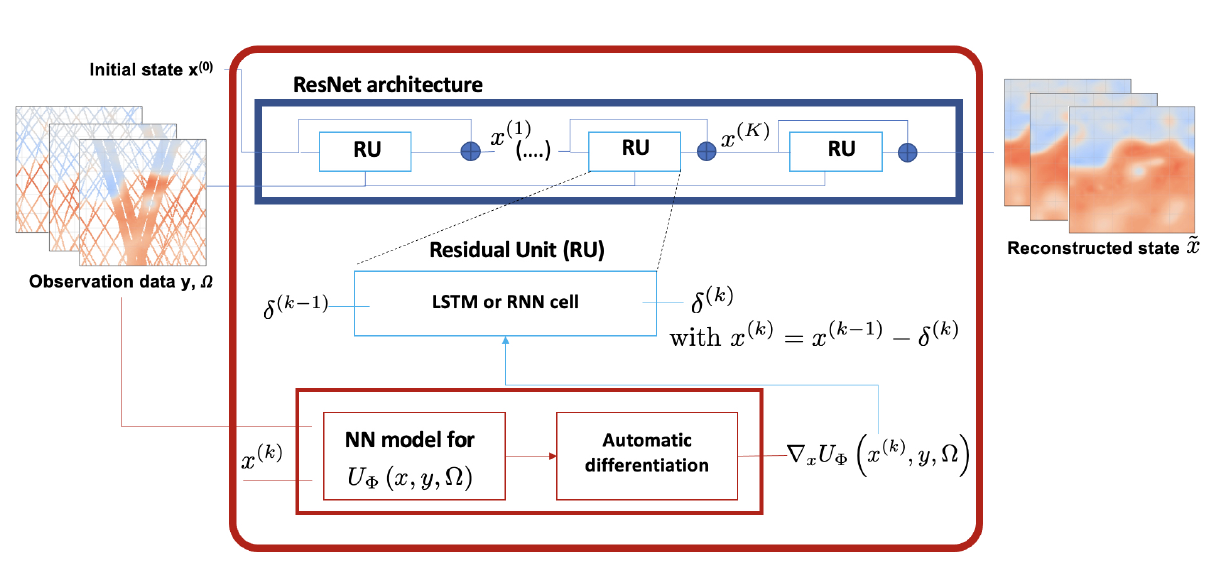
Figure 1. Sketch of the proposed end-to-end architecture for the reconstruction and forecasting of sea surface dynamics from irregularly-sampled satellite observations: the proposed framework relies on the definition of a variational cost U Φ , H from which we derive a gradient-based iterative solver. The latter is implemented as a residual network using a LSTM update rule. We let the reader refer to the main text for a detailed presentation of the variational setting and of the associated